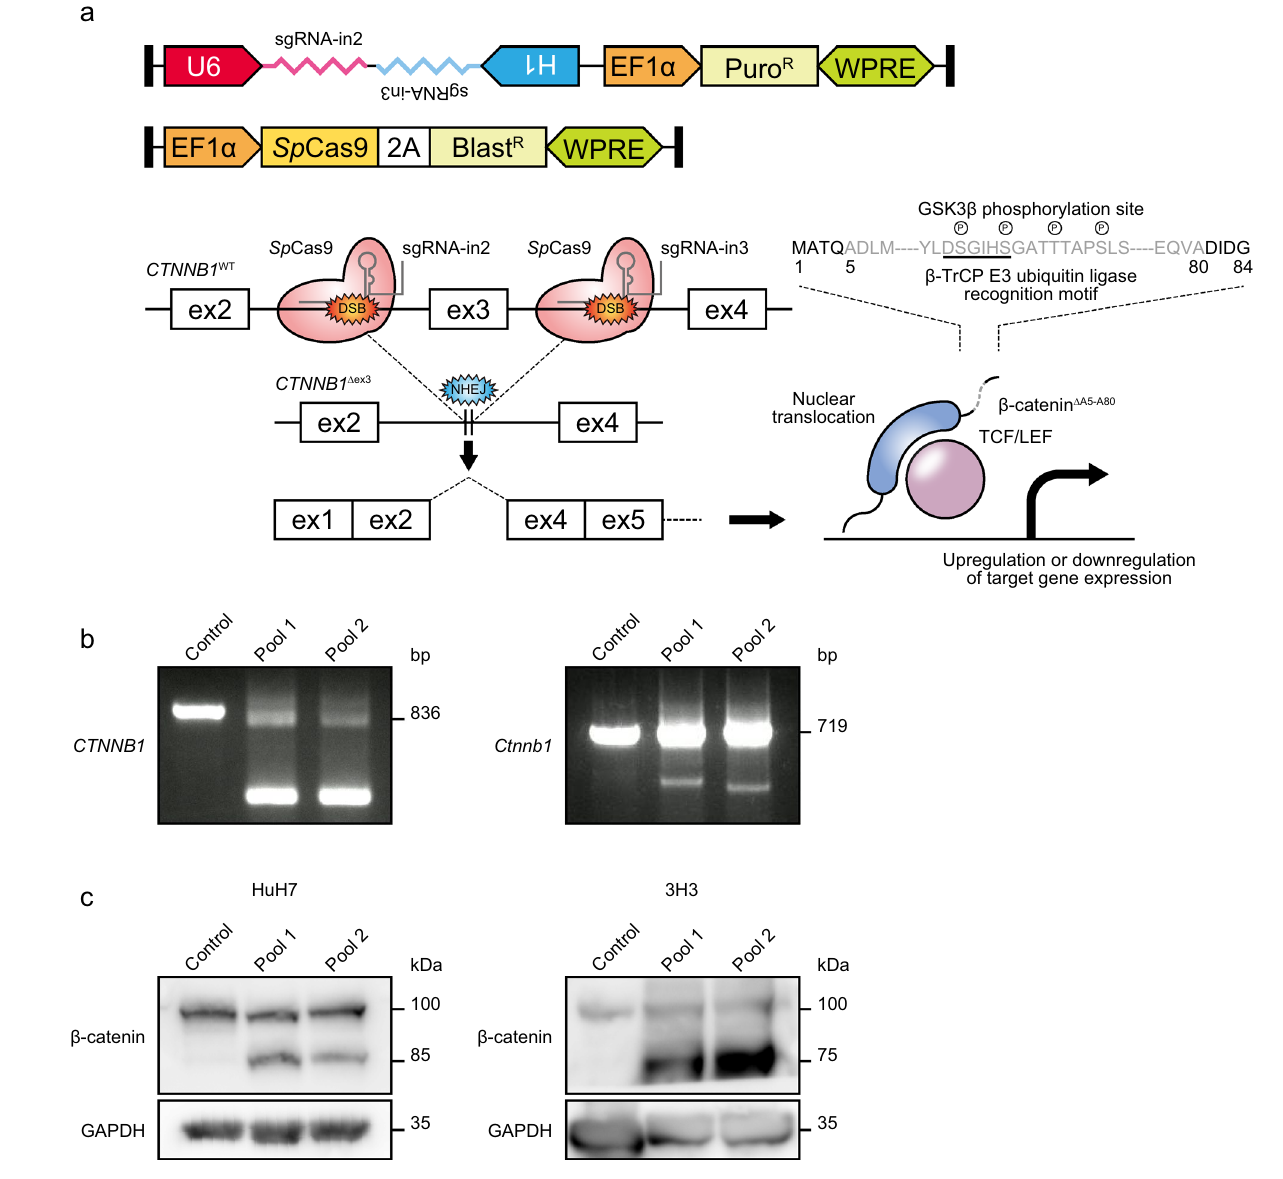
Figure 1. CRISPR/Cas9-mediated exon 3 skipping of β-catenin. ( a ) Schematic representation of exon 3 skipping of β-catenin ( CTNNB1 ). ( b , c ) PCR and immunoblot analysis of β-catenin in human and mouse HCC cell lines, HuH7 and 3H3. The expected PCR product sizes of wild-type and exon 3-skipping β-catenin are 836 bp, 294 bp (pool 1) and 294 bp (pool 2) in humans and 719 bp, 307 bp (pool 1) and 280 bp (pool 2) in mice, respectively. The molecular weights of β-catenin wild-type and β-catenin ΔA5–A80 are 85 kDa and 77 kDa in both humans and in mice. GAPDH was used as a loading control. Full-length gels and blots are presented in Supplementary Figure